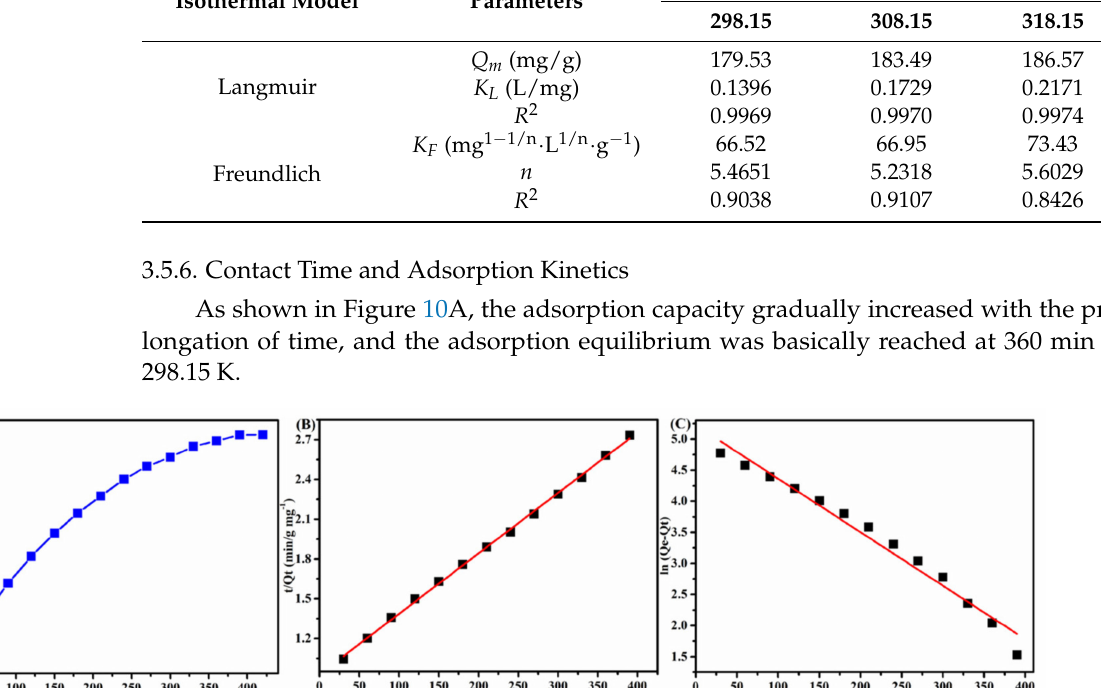
Table 1. Isothermal parameters of Ce(III) on magnetic PMMA-PGMA-PEI. Isothermal Model